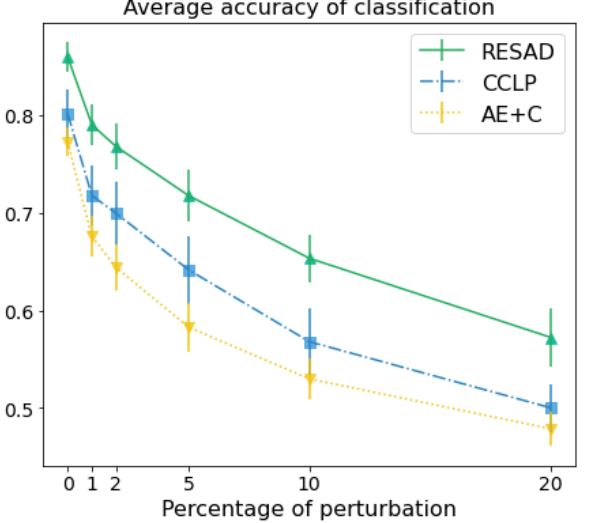
Figure 6. Comparison of average accuracy of classification for our proposed model, CCLP, and AE+C for different perturbation